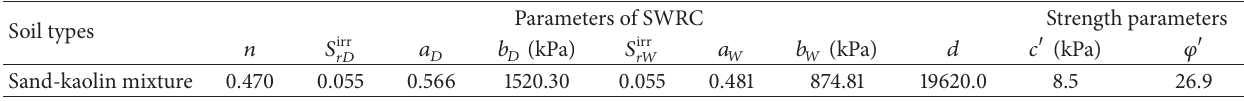
Figure 7: Comparison of tested data with the predictive curve of suction strength and shear strength (measured data from Kayadelen et al. [12]). Table 2: Parameters of SWRC of unsaturated soil and shear strength of saturated soil for predicting suction strength of unsaturated soils that underwent drying/wetting